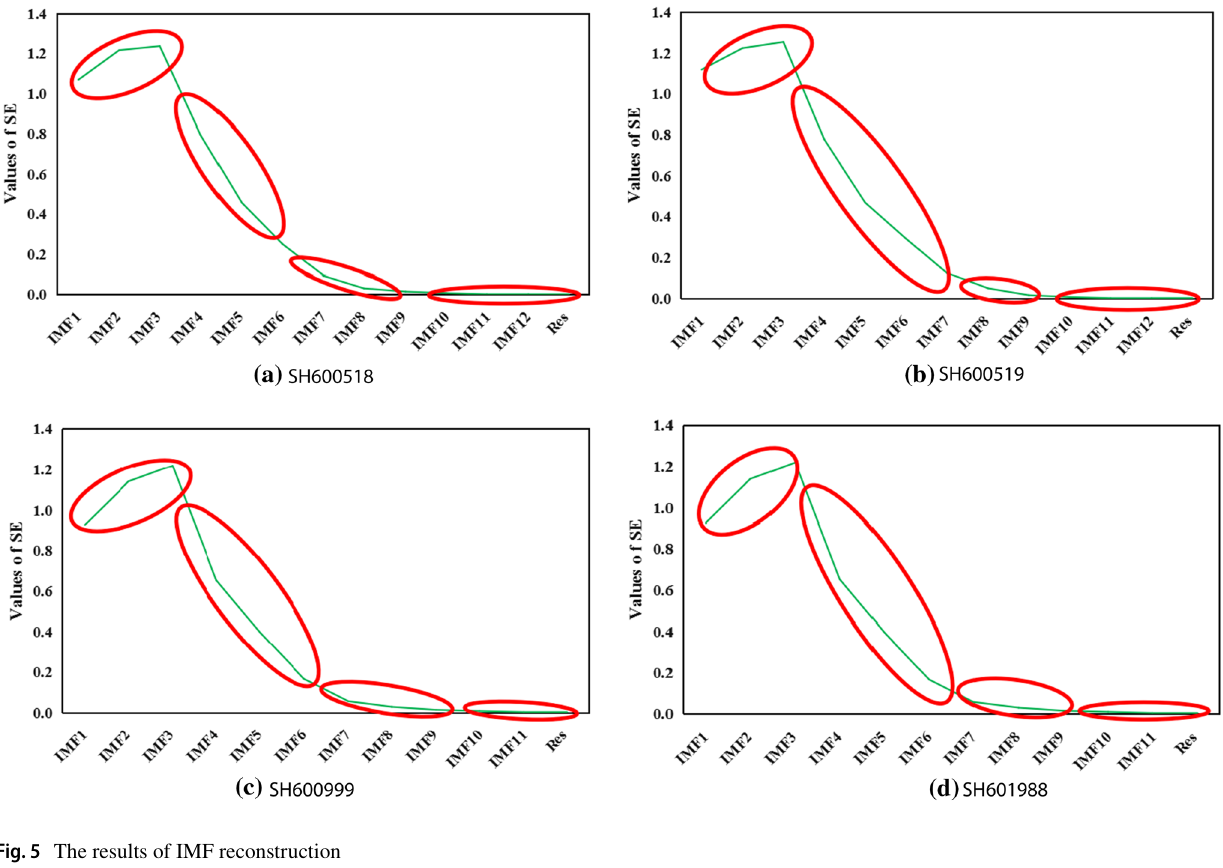
Fig. 5 The results of IMF reconstruction